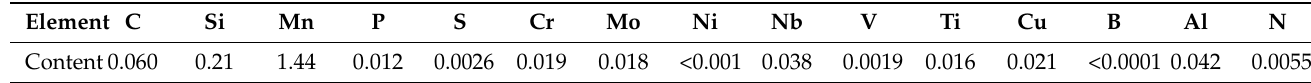
Table 6. Chemical composition of 2# pipeline